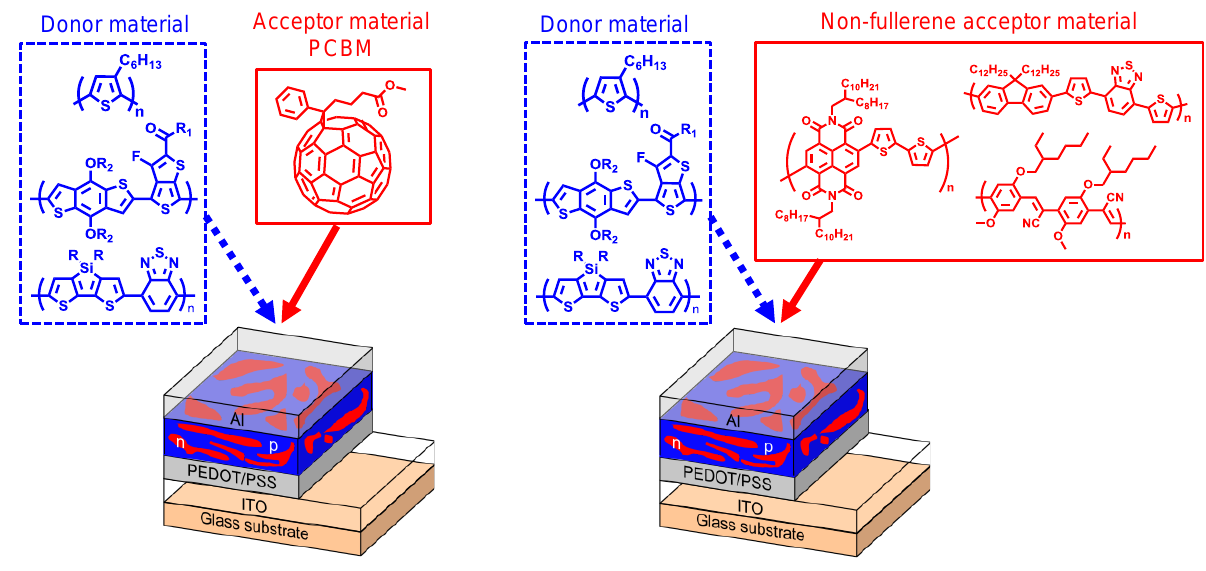
Figure 1. Device architecture of ( A ) polymer/fullerene organic photovoltaics (OPVs) and ( B ) all-polymer solar cells.